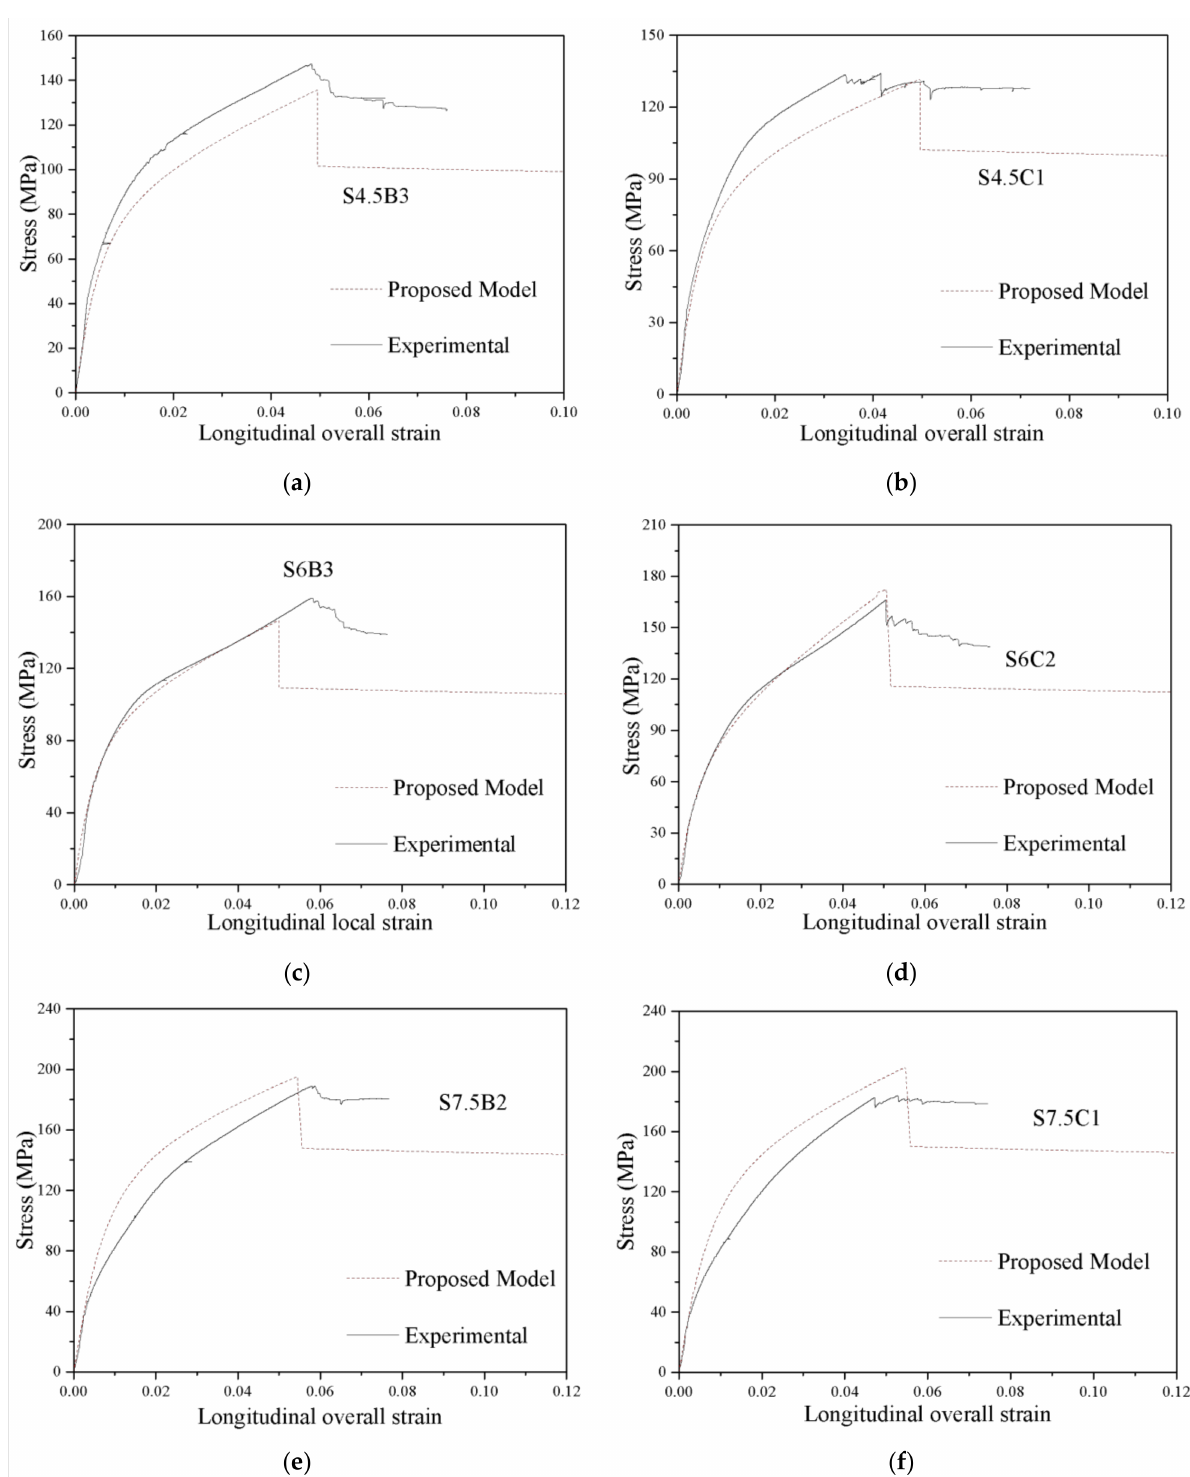
Figure 16. Evaluation of stress-overall strain curves of CFGCT columns. ( a ) S4.5B3. ( b ) S4.5C1. ( c ) S6B3. ( d ) S6C2. ( e )